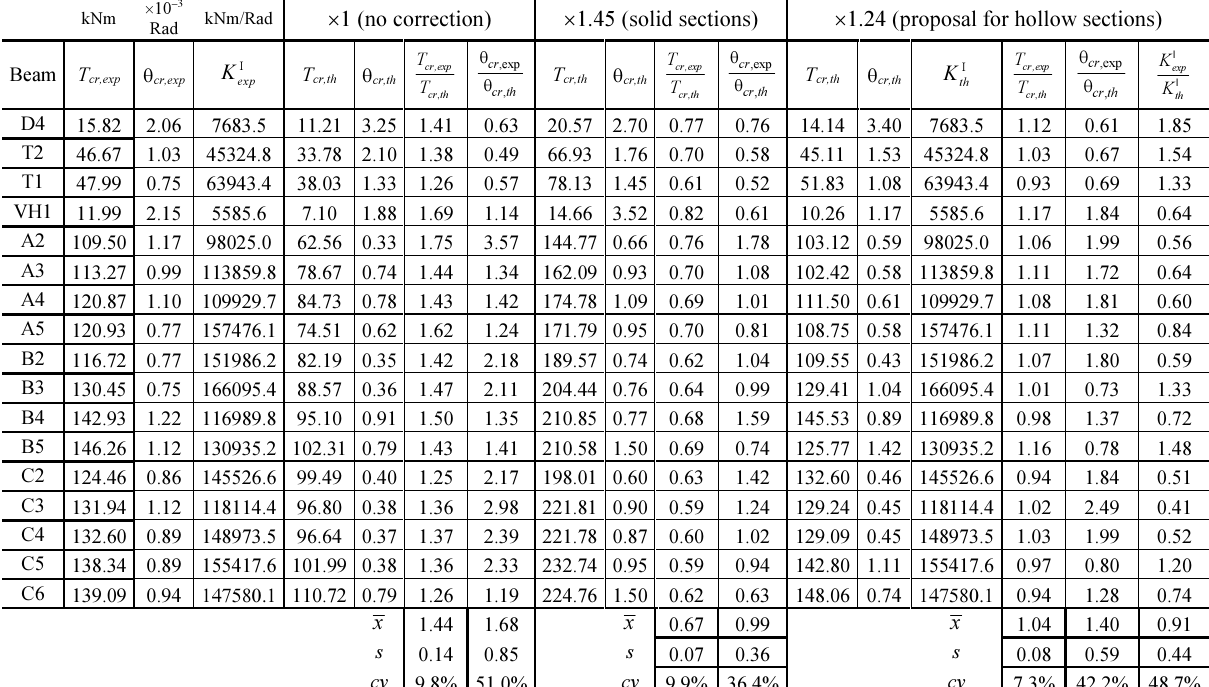
Table 8. Comparative analysis for Zone 1